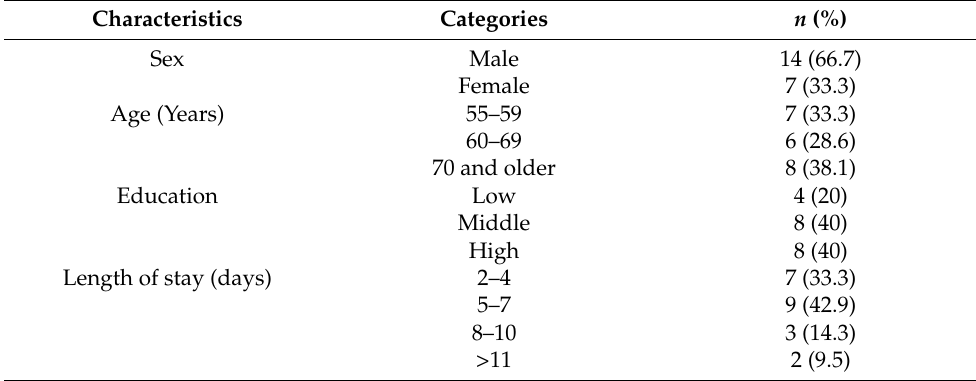
Table 3. Baseline characteristics of the study participants ( n =